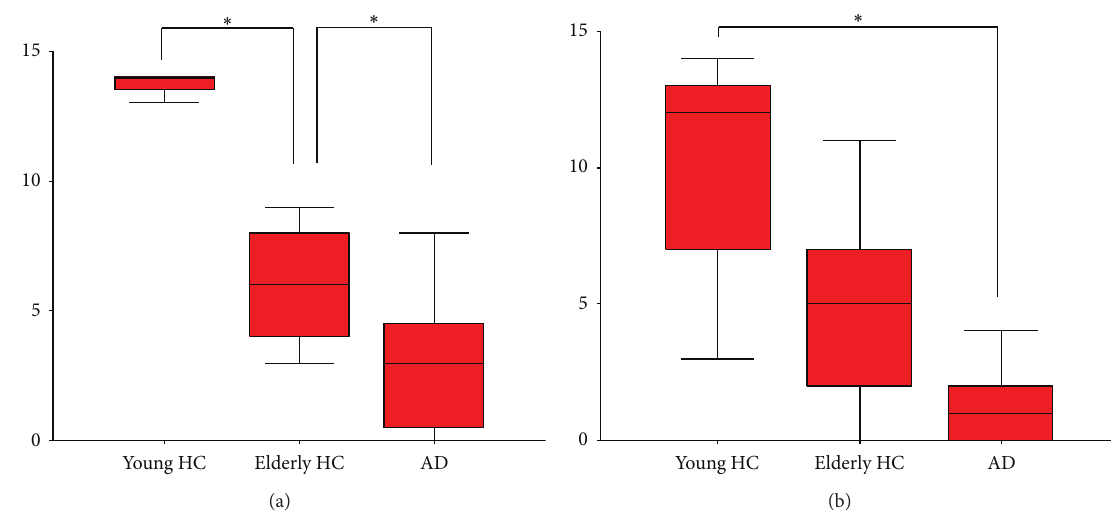
Figure 2: ASA task results under the 60 db (a) and 70 db (b) conditions for three groups. HC: healthy control; AD: Alzheimer’s disease. There is a significant group effect (one-way ANOVA, 𝑃 < 0.01 ) for both conditions. A post hoc test indicated the group differences ( ∗ 𝑃 < 0.05 ).